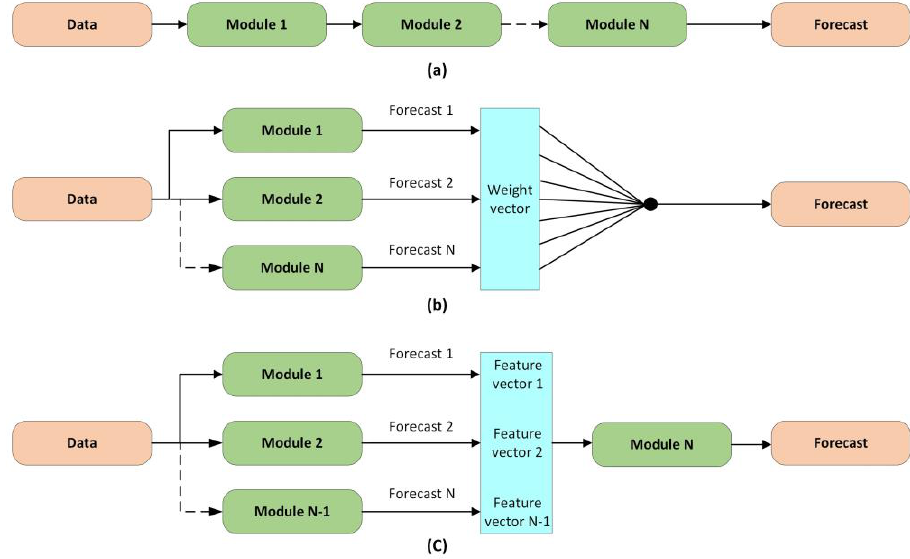
Figure 5. Typical structures of hybrid models. ( a ) Series hybrid model; ( b ) Parallel hybrid model; ( c ) Series-parallel hybrid model.